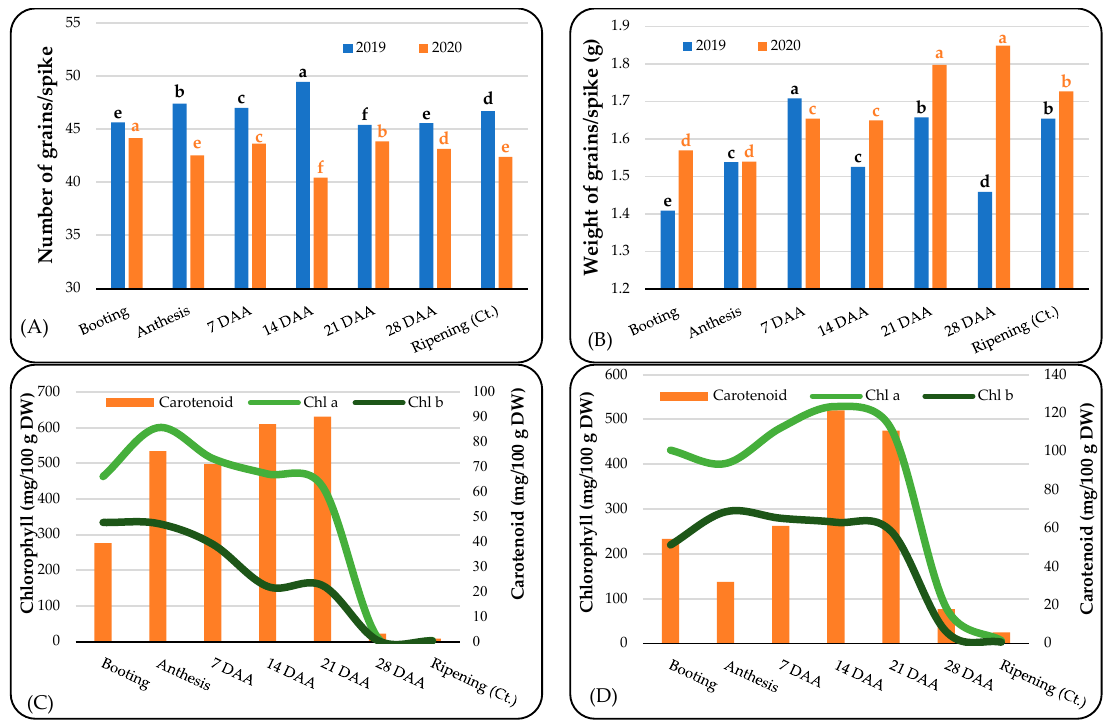
Figure 3. The variation of morpho-biochemical traits of Andrada variety to different flag leaf removal times ( A , B ) number of grains/spike, respectively weight of grains/spike; ( C , D ) photosynthetic pigments-2019, respectively 2020. Different letters in ( A ) and ( B ) figures, the significance is represented according to Duncan Test.